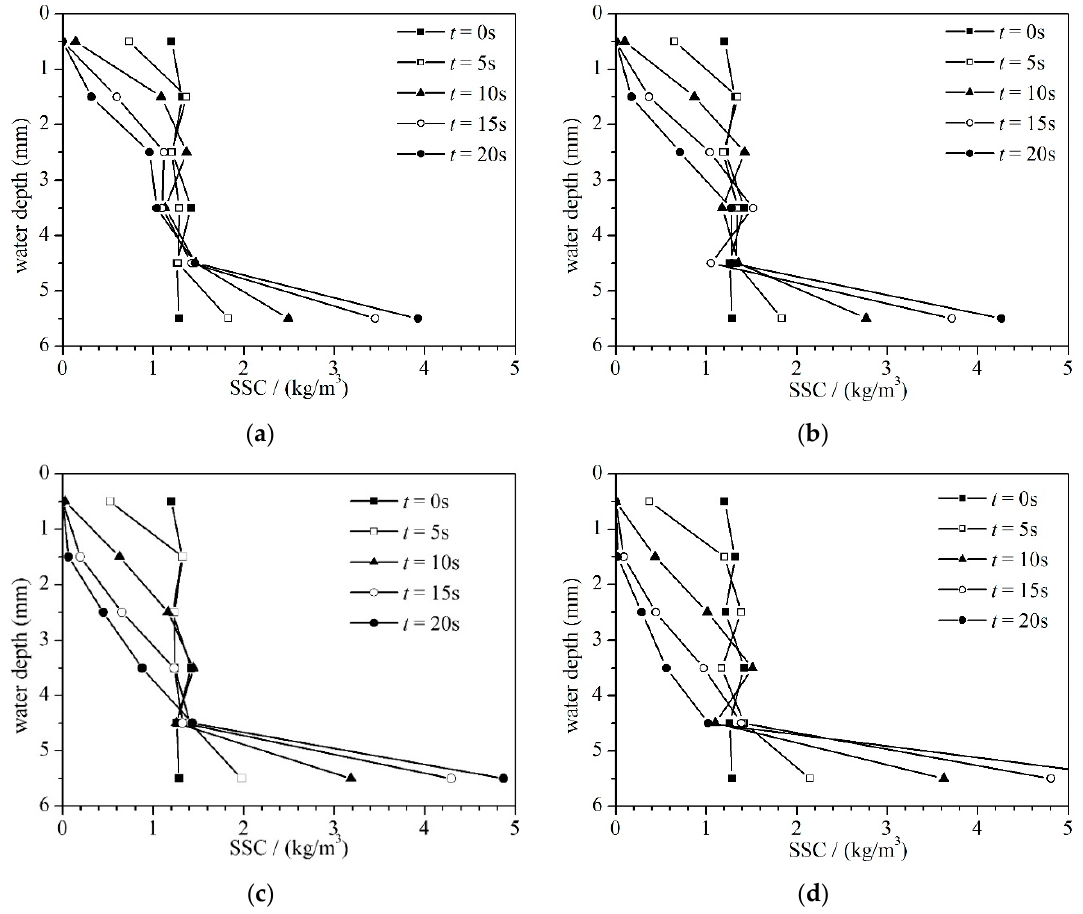
Figure 6. SSC of each water depth in ( a ) 5 °C, ( b ) 10 °C, ( c ) 20 °C, and ( d ) 30 °C. The symbols between two labeled depths represent the SSC between those two depths. The SSC can be statistically obtained by the sediment weight in this zone. It was generally stable at depth of 4.5 mm, but there were some small differences between the cases.